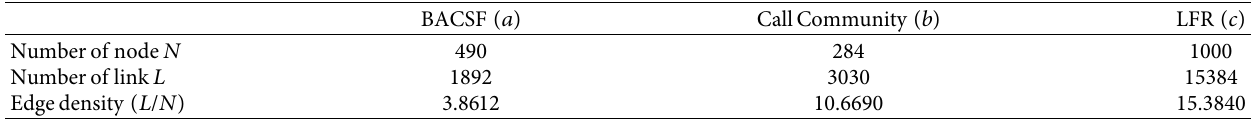
Table 2: Undirected network dataset.